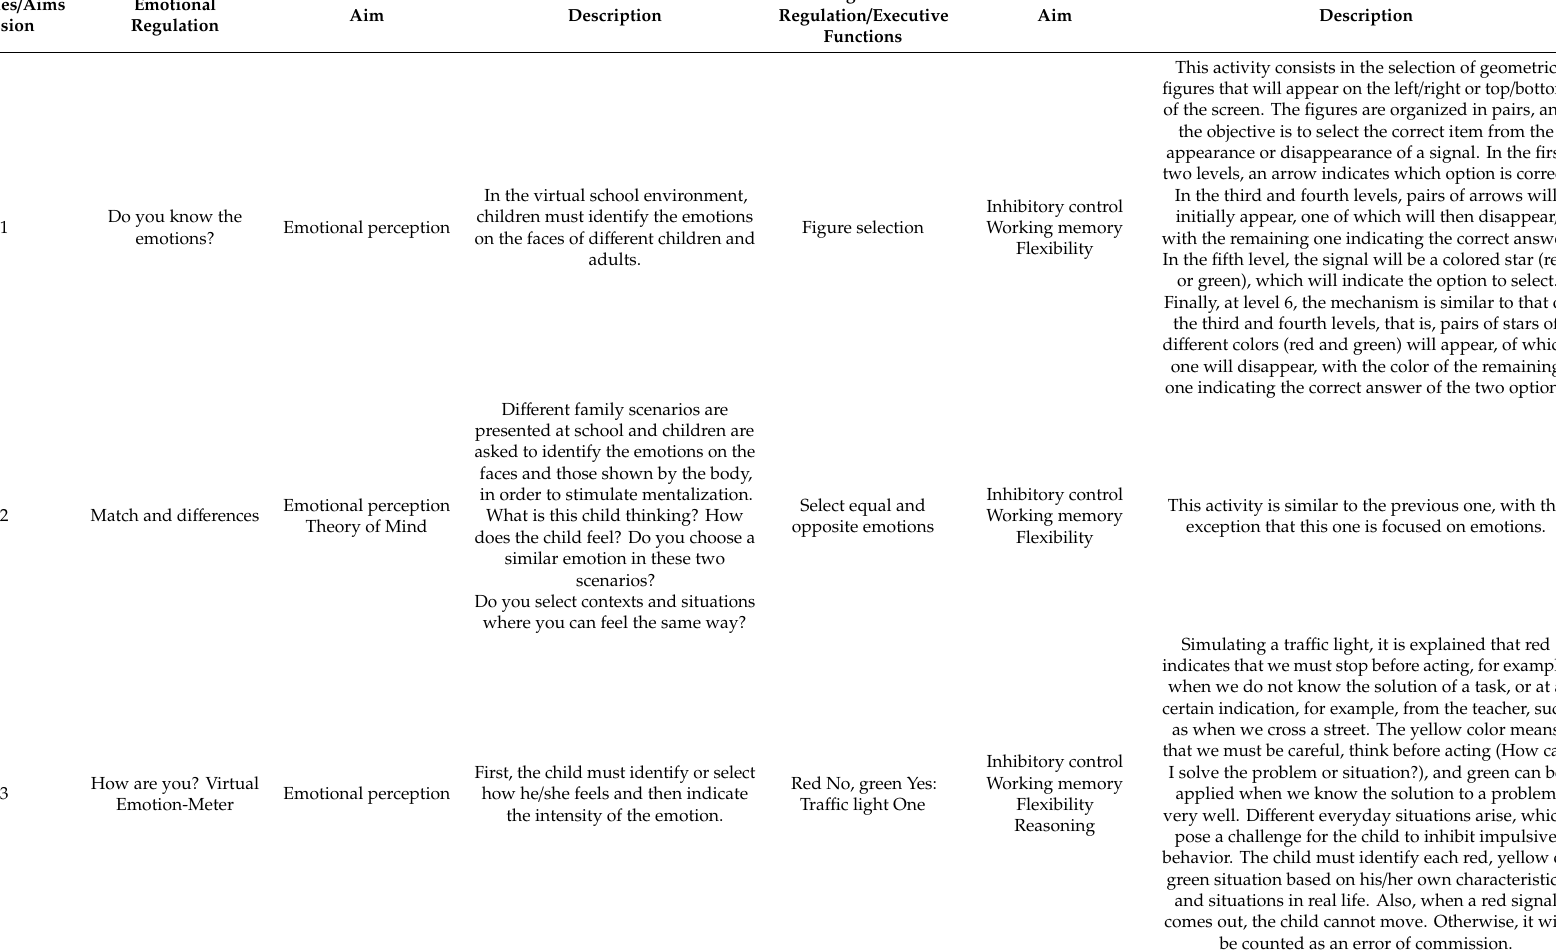
Table 2. Organization, description and aims of each session for Experimental Group.